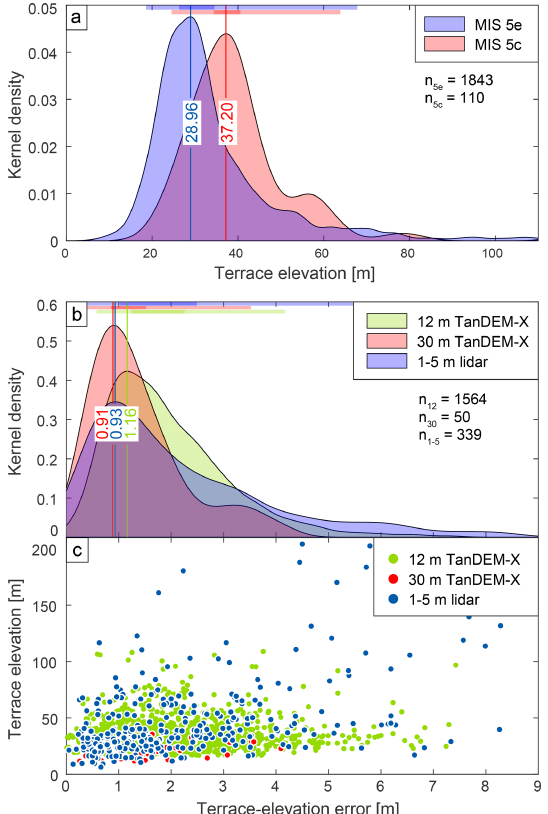
Figure 10. Statistical analysis of measured shoreline-angle eleva- tions. (a) Kernel-density plot of MIS 5e and 5c terrace elevations with maximum likelihood probabilities (MLPs) at 28.96m elevation for MIS 5e and 37.20m elevation for MIS 5c ( n : number of mea- surements). Colored bars on top highlight the standard deviations σ and 2 σ . (b) Kernel densities and their associated standard-deviation ( σ and 2 σ ) calculations of terrace-elevation errors for source DEMs of various resolutions. The measurements on the most abundant DEM, the 12m TanDEM-X, have an MLP error of 1.16m, while the 30m TanDEM-X and the 1–5m lidar produce slightly lower errors of 0.91 and 0.93m, respectively. (c) Terrace-elevation errors plotted against terrace elevation for the individual source DEMs. Although the point density for high terrace elevations is low, a weak correla- tion of high errors with high terrace elevations can be